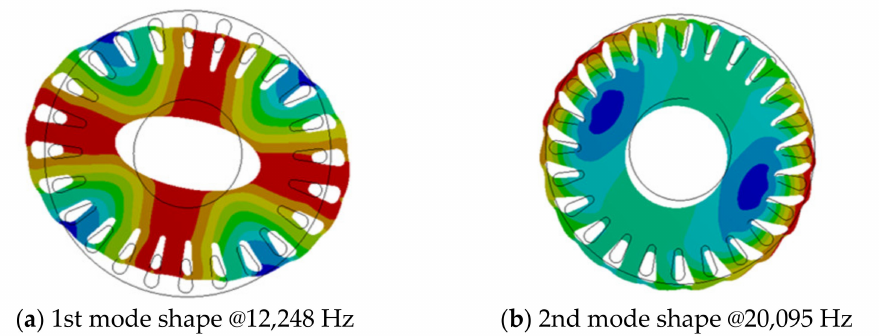
Figure 10. Natural frequency of